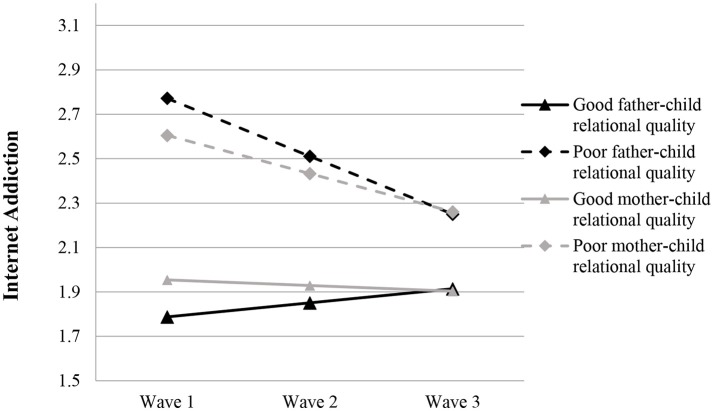
Growth trajectories of adolescent Internet addiction as a function of parent-child relational qualities. The figures were plotted based on Model 4c shown in Table 6. Good quality indicates 1SD higher than the mean value; poor quality indicates 1SD lower than the mean value.